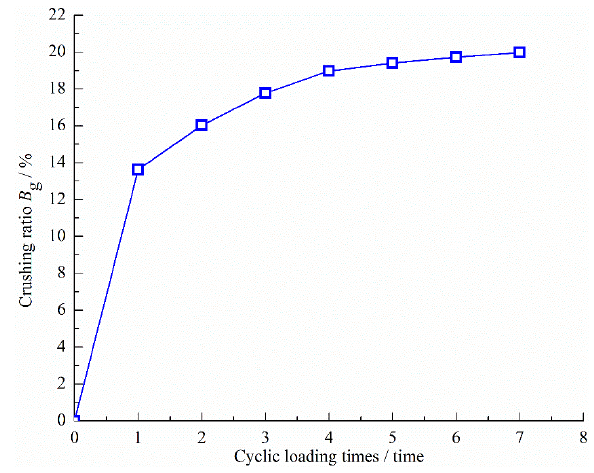
Figure 7. The relationship between the particle-crushing ratio B g and cyclic loading times.